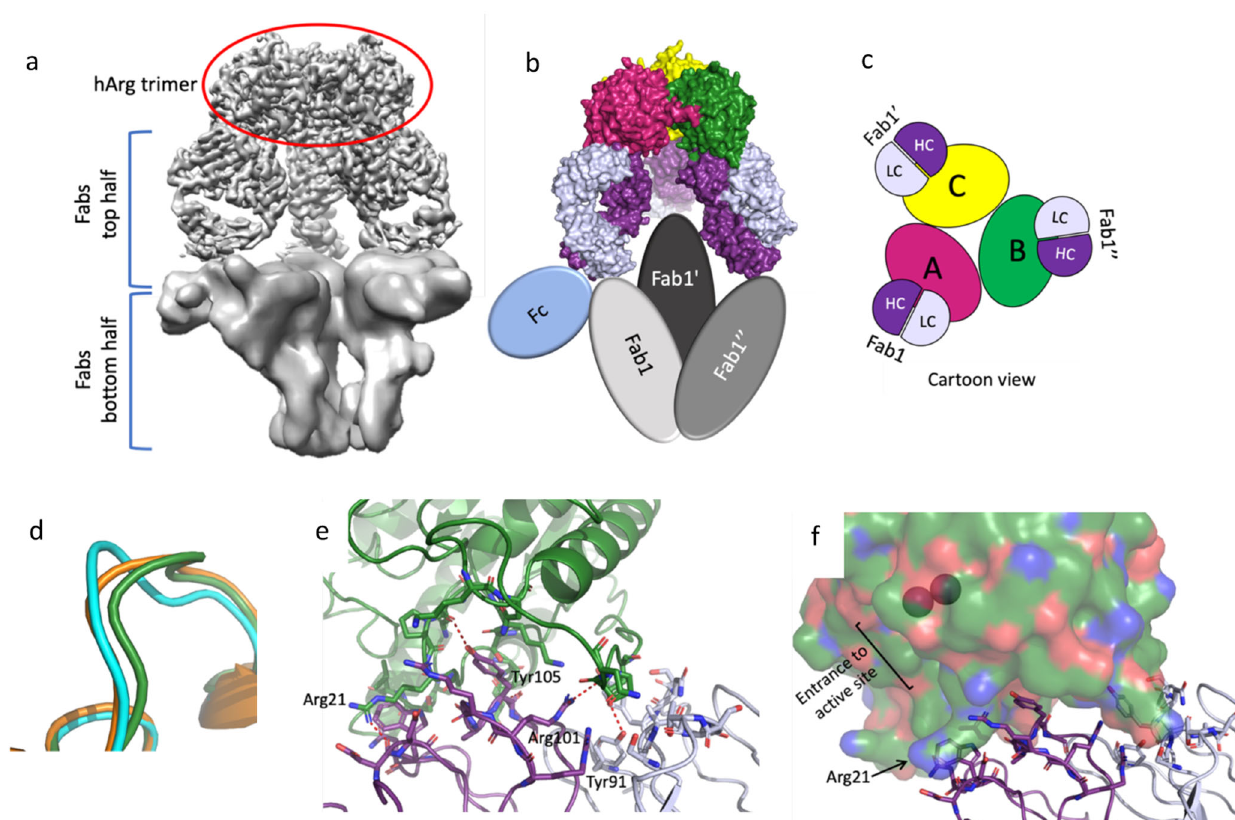
Fig. 5 Overall complex formation and epitope mapping for mAb5 1:3 complex. a Density for the bottom half of the complex is almost completely absent. In masked maps at very low contour it is possible to visualize some density for the other Fabs and the Fcs, but the Fabs on the bottom half appear to be in a different conformation and closer to each other with no density for Arginase trimer present. b This panel shows an overview of how the 1:3 hArg1 to mAb5 complex assembles, with the three monomers of the hArg1 trimer colored in green, pink, and yellow, and the mAbs colored in dark purple (heavy chain) and pale purple (light chain). The protein surfaces are shown for the top half of the complex, and the bottom half Fabs and one Fc shown in colored ovals. c A depiction of the complex for ease of interpretation is shown. Each antibody interacts with only one hArg1 monomer and these interactions are symmetric around the trimer. d The loop containing residues Lys16-Val24 is shown for hArg1 bound to mAb5 antibody (cyan), hArg1 bound to mAb1 (green), and hArg1 bound to a small molecule (orange) are depicted. e Details of the interactions between the Fab and the hArg1 monomer are shown, with several residues involved in hydrogen bonding interactions labeled. f A surface view of one of the hArg1 monomers (green) shows that the active site is fully exposed in this complex. The binuclear active site manganese ions are shown as purple spheres.